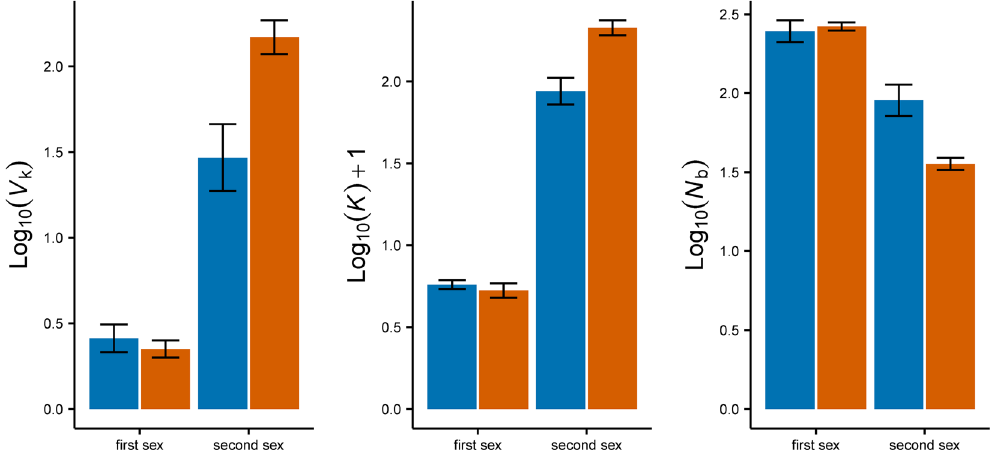
Figure 4. Interaction plots of some annual key parameter estimates (obtained with AgeNe) in each life history strategy per sex. ¯ k : annual mean number of offspring; V k : annual variance in reproductive success; N b : annual effective number of breeders. Values are log 10 transformed to improve visualization. Protandry in blue; protogyny in